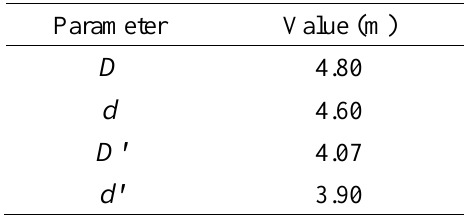
Table 1. Tower diameters used for further